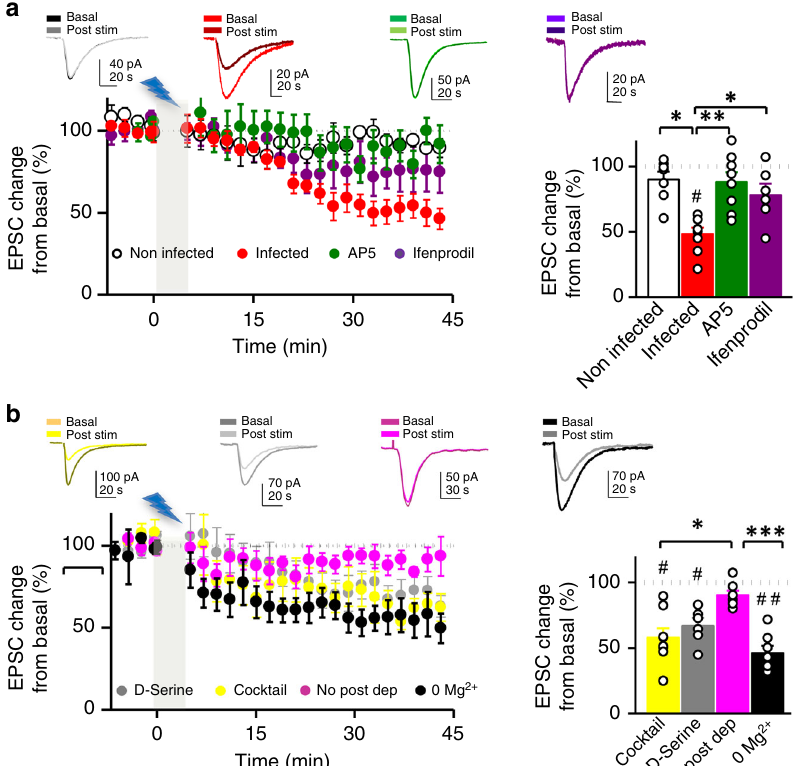
Fig. 4 Optogenetic low-frequency stimulation of astrocytes induces NMDAR-dependent LTD. a (Left) Time course of CA3-CA1 EPSC amplitudes during a photostimulation experiment (gray bar) from control (non-infected) (white, n = 7) or Ch2R-expressing organotypic hippocampal slices (red, n = 8), in presence of the NMDAR antagonist AP5 (green, n = 8) or the GluN2B-selective antagonist ifenprodil (purple, n = 6). (Right) Average values of EPSC amplitude relative to baseline, 45 min after the onset of photostimulation. Representative traces with matching colors are shown above the graphs. Wilcoxon was used for assessing LTD expression with respect to baseline ( # P < 0.05). Differences between groups were determined by Kruskal – Wallis test followed by Dunn ’ s test. (* P < 0.05; ** P < 0.01). b Relative changes and summary of results of EPSC amplitude over time before and after astrocyte photostimulation in the presence of saturating concentrations of D -serine (10 µ M, gray, n = 6); a cocktail containing GABA A (picrotoxin, 50 µ M), GABA B (saclofen, 100 µ M), P2 purinergic (suramin, 100 µ M), muscarinic cholinergic (atropine, 50 µ M), CB1 cannabinoid (AM251, 2 µ M), A1 adenosine (CPT, 10 µ M), and metabotropic glutamate (MCPG, 0.5 mM) receptor antagonists (yellow, n = 8); without postsynaptic depolarization (pink, n = 7) and without postsynaptic depolarization in 0 Mg 2 + (black, n = 7), in organotypic hippocampal slices. Differences between groups were determined by Kruskal –